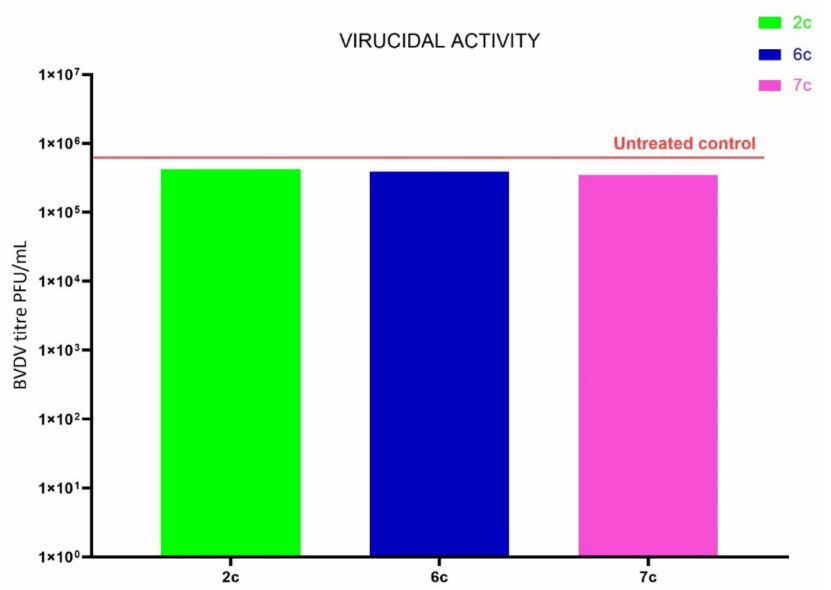
Figure 3. Virucidal activity of the 2c , 6c and 7c compounds. BVDV suspensions were incubated with the title compound at 4 ◦ C for 1 h, and then the remaining infectivity was determined. Results are expressed as a titer reduction in compound-treated samples compared to non-treated ones.